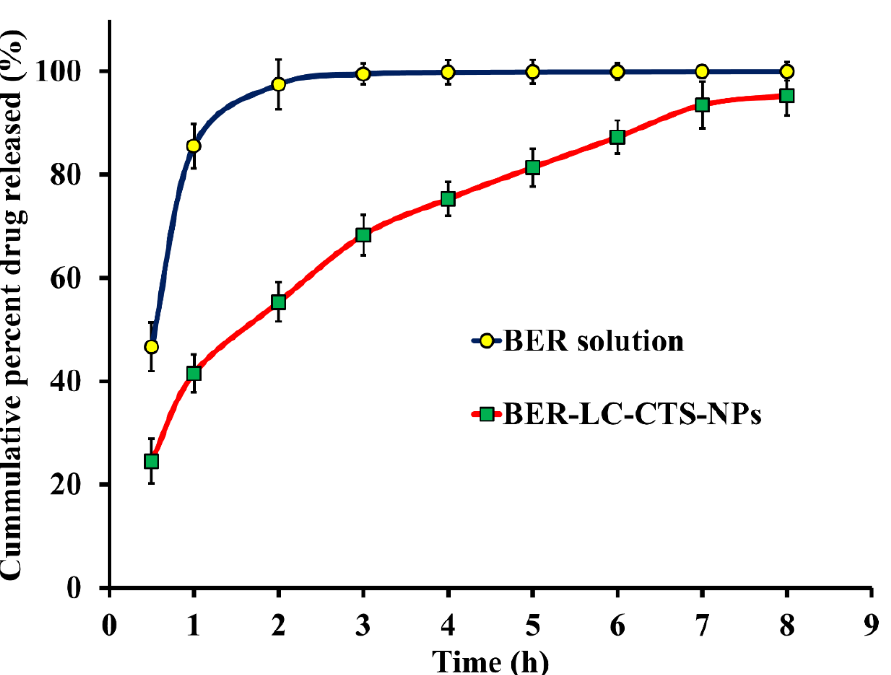
Figure 3. In vitro release profile study of BER from optimized BER-LC-CTS-NPs and BER solution through dialysis membranes.